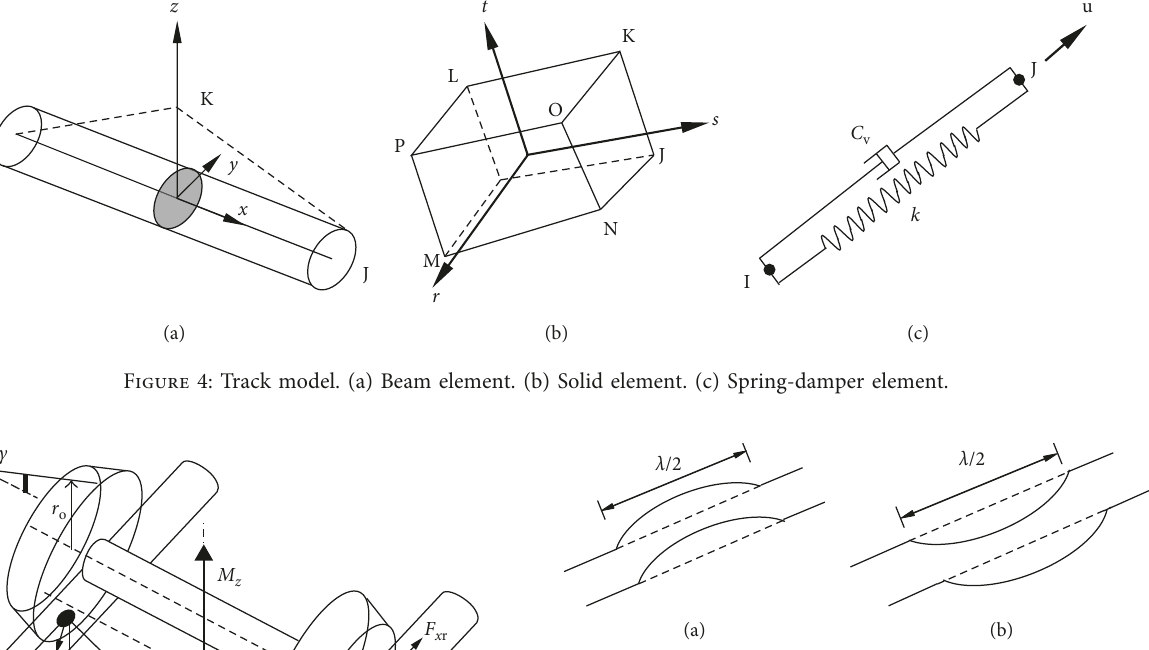
Figure 7: Track irregularities. (a) Longitudinal level. (b) Track